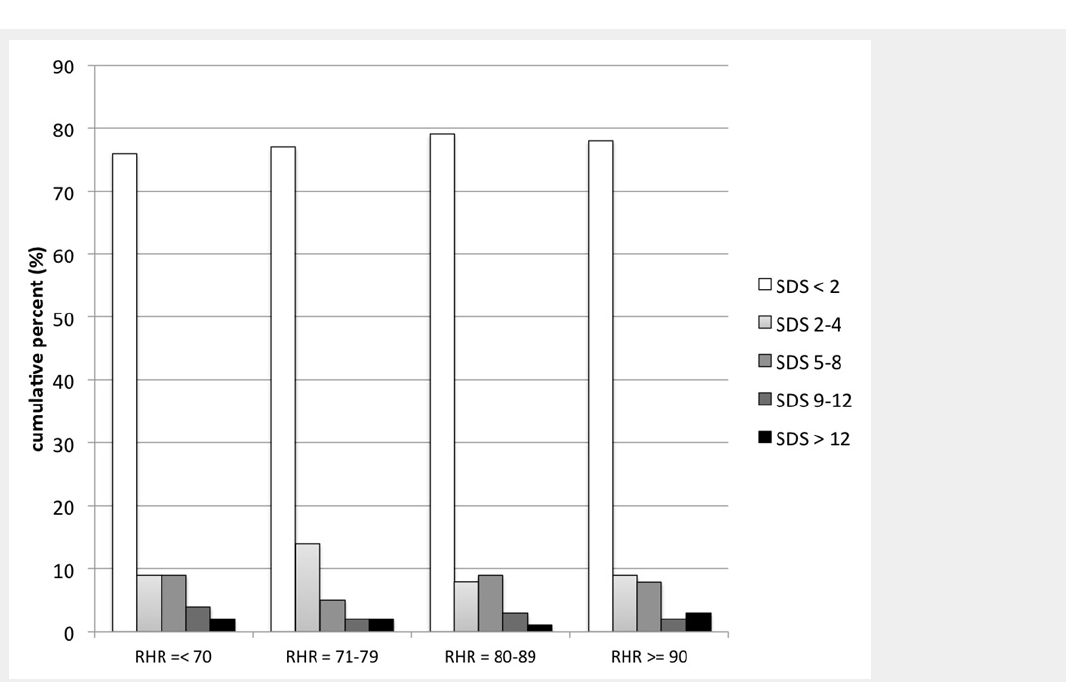
Graphics illustrating the interrelation between the quartiles of resting heart rate (RHR in bpm) and the severity of myocardial ischaemia (SDS),